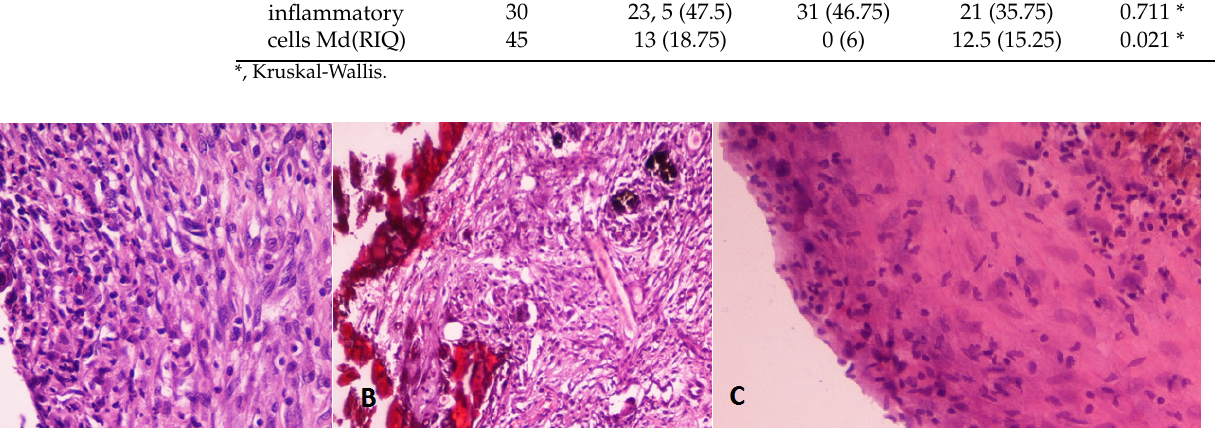
Table 4. Qualitative variables MTA, MTA-G3 and Theracal, 15 days.